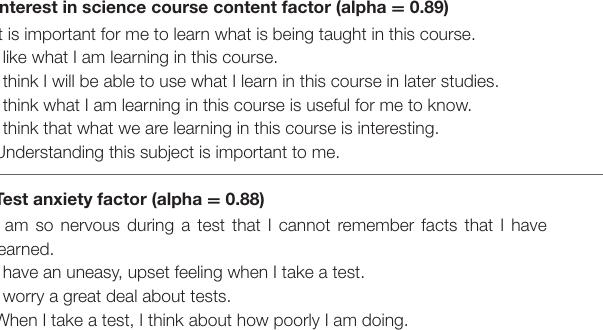
TABLE 2 | Items used in a survey of students in courses offered by the College of Biological Sciences (CBS) and the College of Science and Engineering (CSE) at the University of Minnesota ( N =